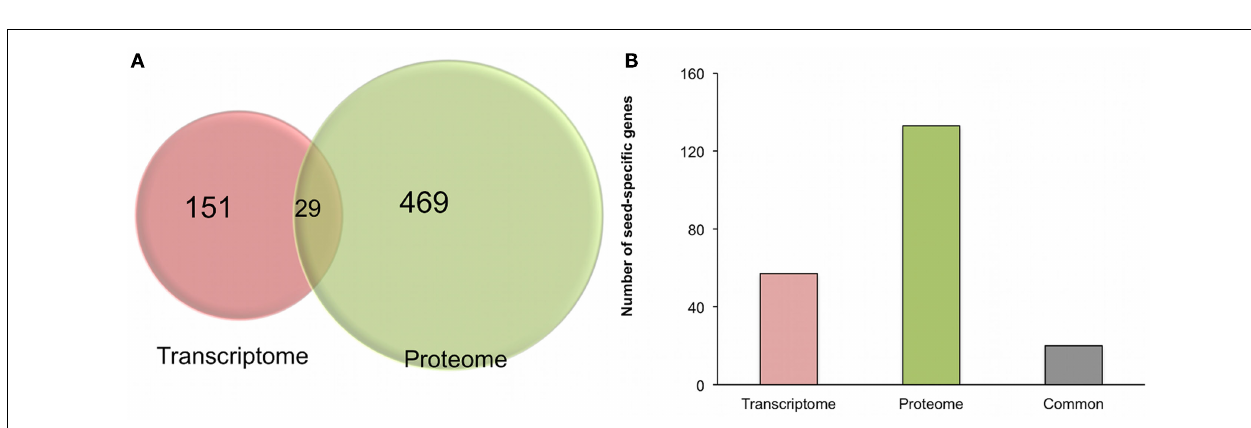
the “leaf,” “root,” “flower,” and “seed” samples. Only samples commonly used in the two studies (i.e., flower, leaves, root, and seed) were compared. (B) Number of seed-specific genes identified by transcriptome (Schmid et al., 2005), proteome (Baerenfaller et al., 2008) or both